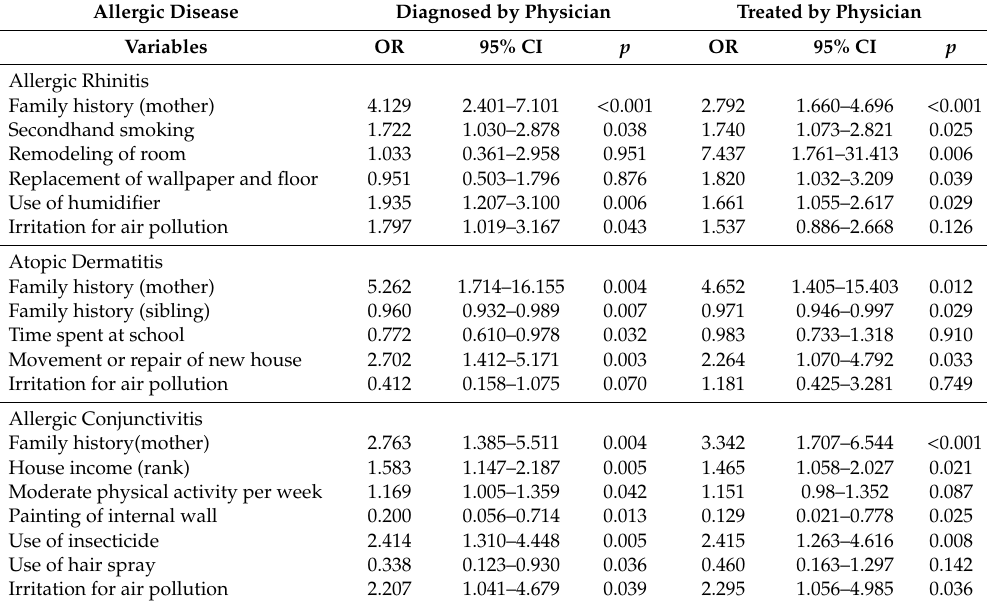
Table 5. Results of generalized estimating equations for allergic disease prevalence changes as a function of environmental risk